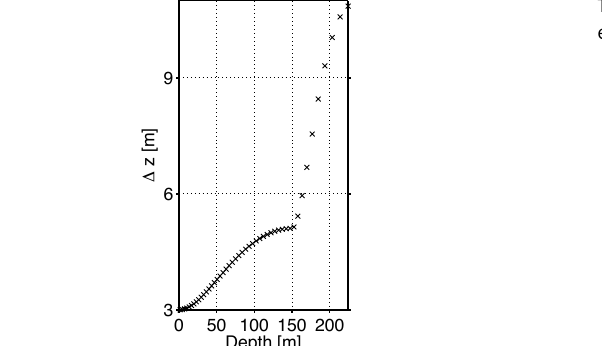
Fig. 2. Vertical model grid. The nominal box thicknesses ( ∆ z ) as a function of depth. Figure 2. Vertical model grid. The nominal box thicknesses ( 1z ) as a function of depth.